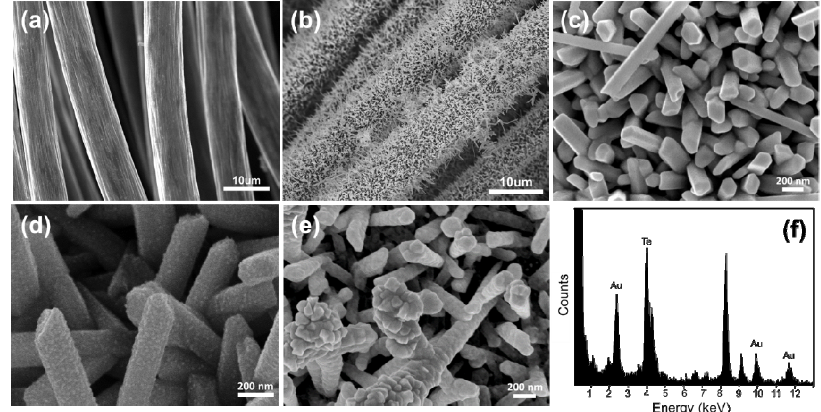
Figure 2. ( a – c ) SEM images of the carbon fiber fabrics before ( a ) and after ( b , c ) the growth of Te NWs; ( d , e ) SEM images of the Au-Te NW-based carbon fiber fabrics when using Te NW-based carbon fiber fabrics to react with 0.5-mM ( d ) and 2-mM ( e ) HAuCl 4 ; ( f ) EDX spectrum of the Au-Te NW-based carbon fiber